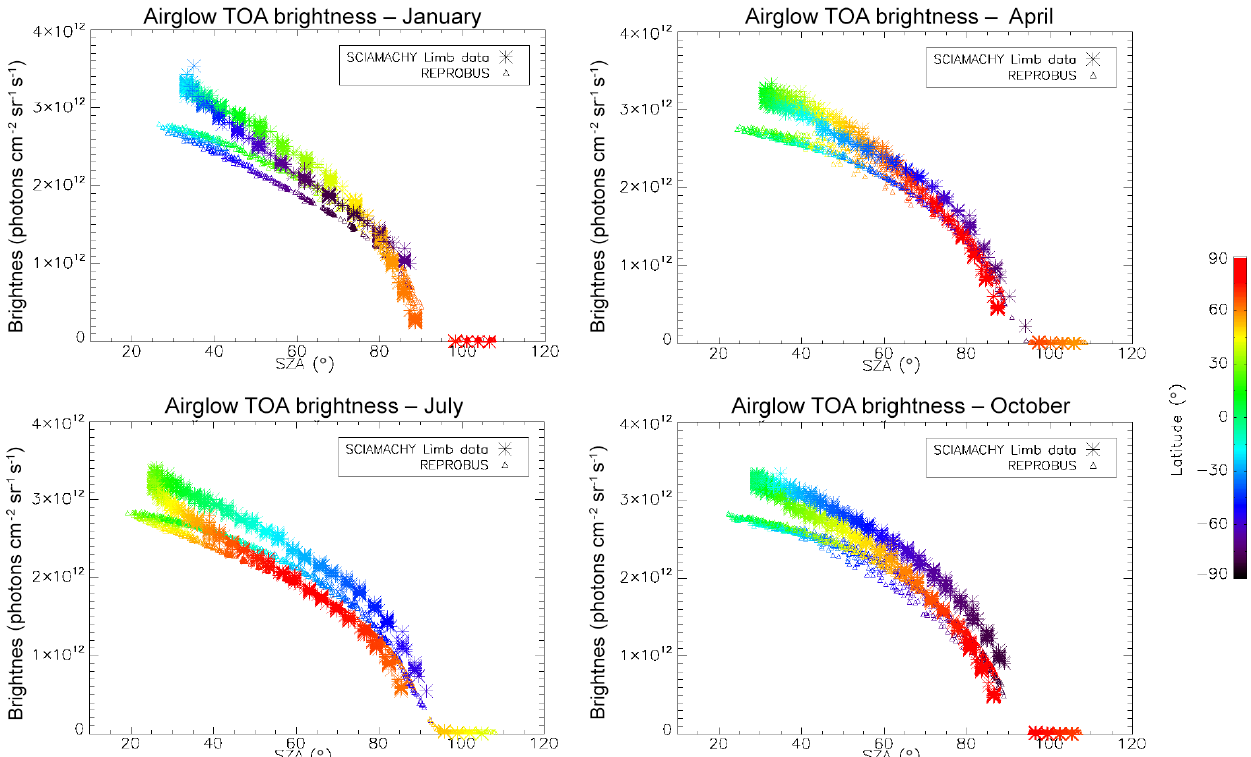
Figure 11. Airglow intensity seen at nadir as a function of SZA for the months of January, April, July, and October 2007 (first 3d of each month only). Data (star symbol) come from the SCIAMACHY limb data (retrieval of VER with onion-peel inversion and subsequent vertical integration); other data ( (cid:49) symbol) are from the REPROBUS/airglow model. The colour scale for symbols represents latitude. The SZA for the SCIAMACHY curve was recalculated with an external tool. The data are systematically larger than the model but overall behaviour is similar.